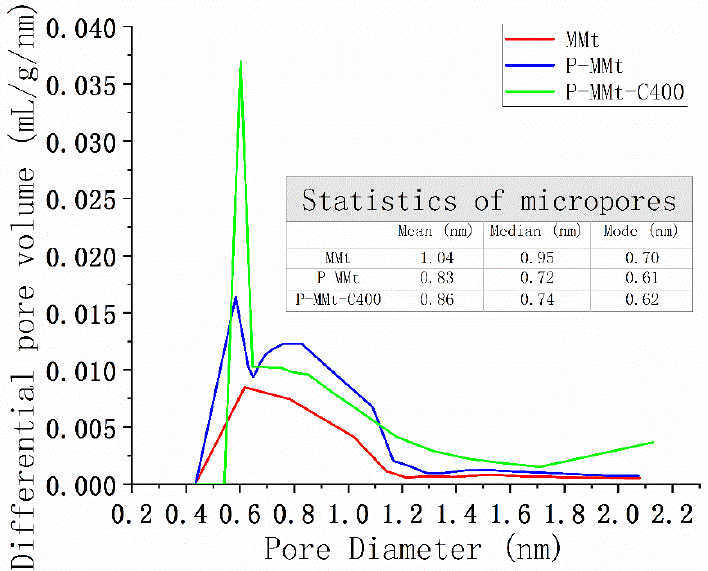
Figure 4. Micropore distribution of MMt, P-MMt, and P-MMt-C400 (calculated by the Horvath– Kawazoe model).